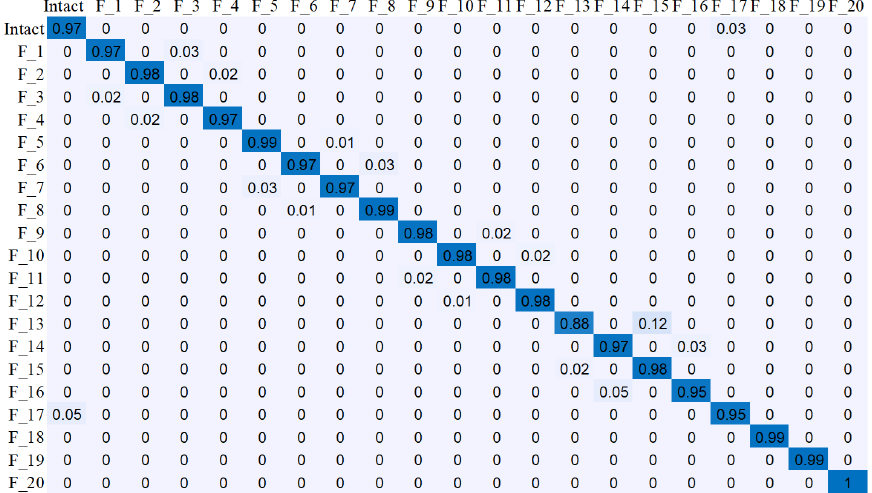
Figure 18. Confusion matrix of the different environmental condition (Hs = 7 m, Tp = 12 sec) (Accuracy: 97.2%).